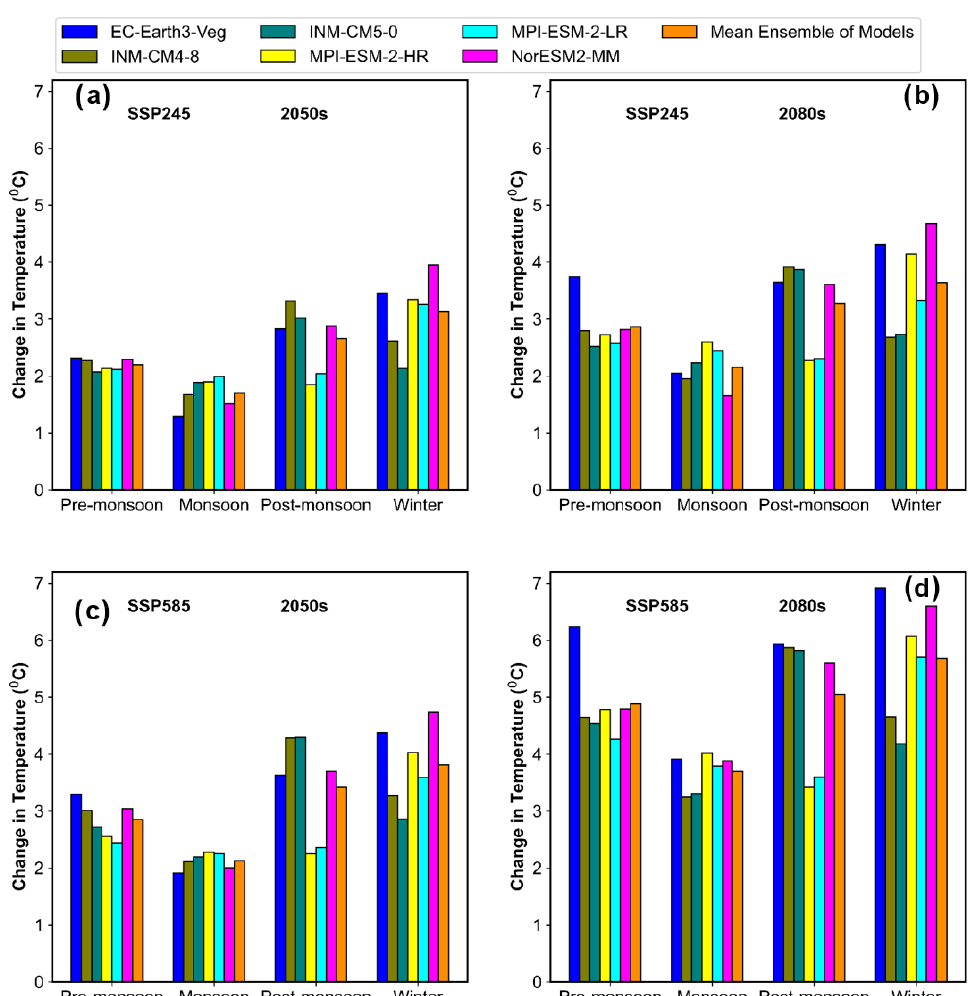
Figure 15. Projected changes in the mean seasonal minimum temperature ( T min ) in the sub-basin using different CMIP6 GCMs under the SSP245 and SSP585 scenarios in the (a, c) 2050s and (b, d)